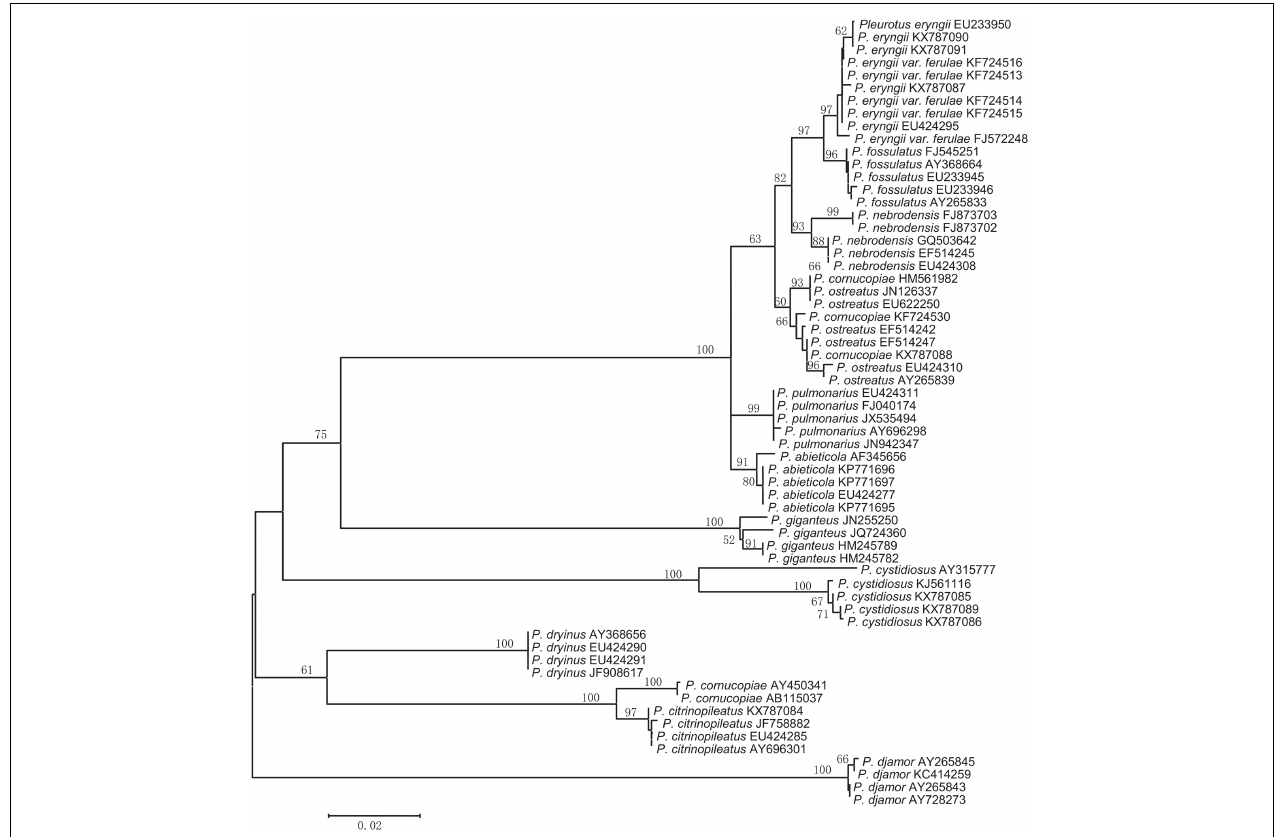
FIGURE 2 | Neighbor-joining tree based on the ITS sequences from the Pleurotus